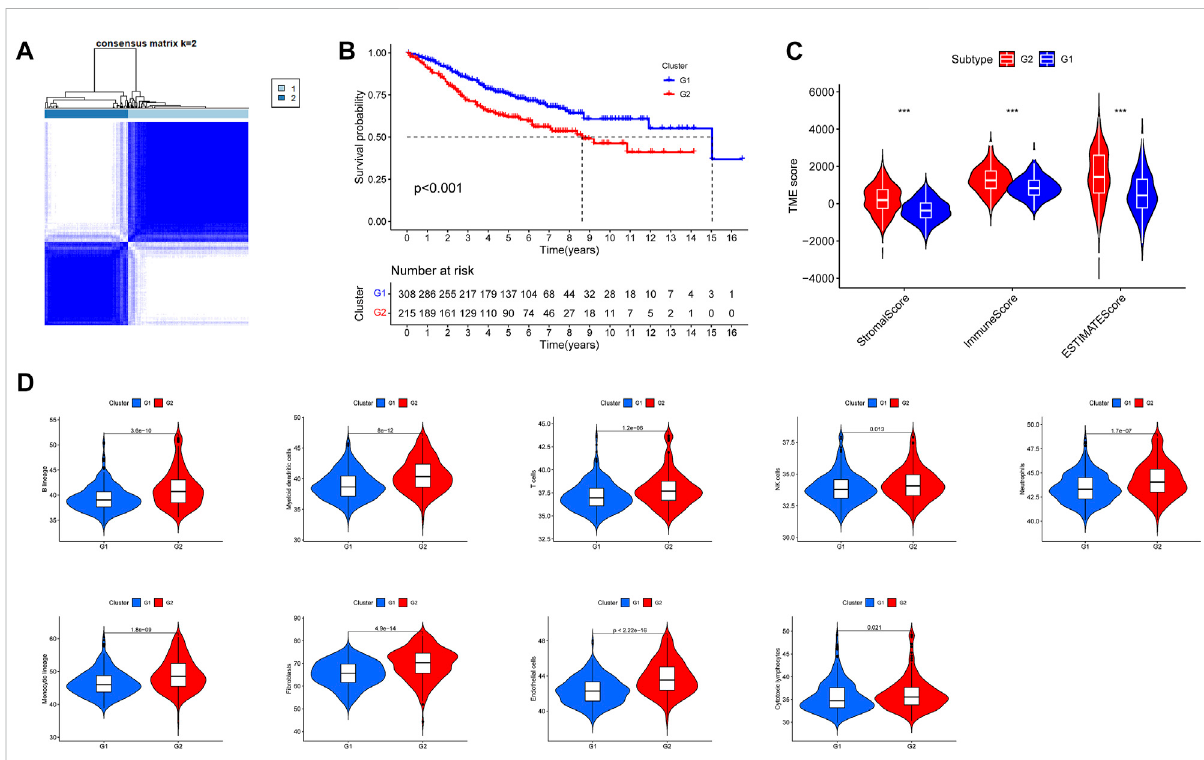
FIGURE 1 Subgroups of COAD (Colon Adenocarcinoma) de fi ned by prognosis-associated RNA processing factor genes. (A) The TCGA cohort ’ s consensus scorematrixforallsampleswhen K =2.Whentwosampleshadahigherconsensus scoreindistinctinteractions, theyweremorelikelyto be clustered together. (B) OS curves based on COAD patients from the TCGA cohort for the two RNA processing factor clusters. (C) Comparations betweenthetwosubgroupsintermsofstromalscore,immunescore,andESTIMATEscoreintumortissues. (D) Comparationsbetweenthetwo subgroups in abundance of immune fi ltrating cells in tumor